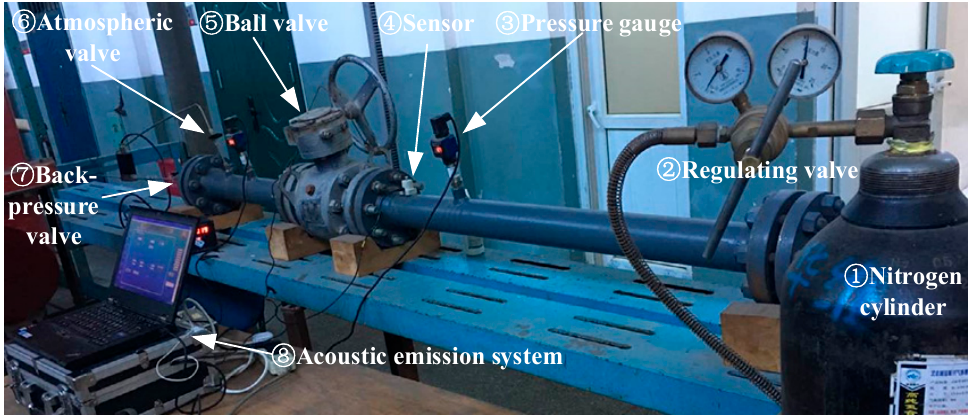
Figure 3. Experimental platform for detection valve internal leakage in the gas